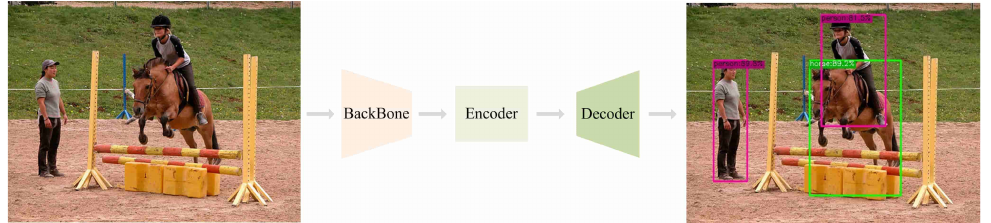
Figure 2. Object detection workflow